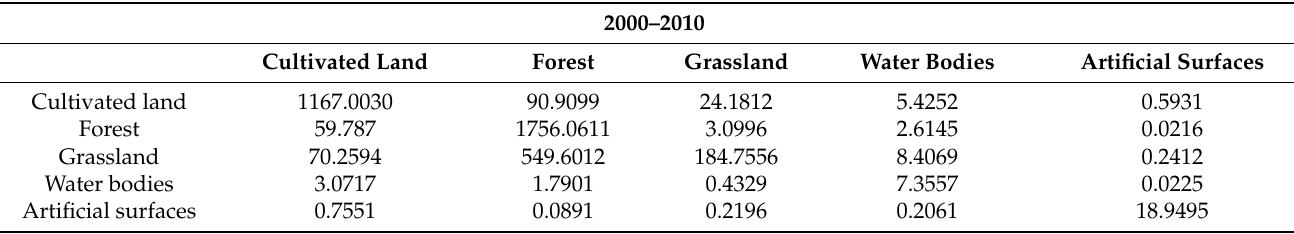
Figure 4. The area of land-use change in Enshi City from 2000 to 2020. The bar plot combines both gross changes and net changes. Bars extending to the upper side of zero refer to gross gain (shown in grey) and net gain (shown in green). Bars extending below zero refer to gross loss (grey) and net loss (red). Table 1. Transition matrix of land-use types in Enshi City from 2000 to 2010 (km 2 ).